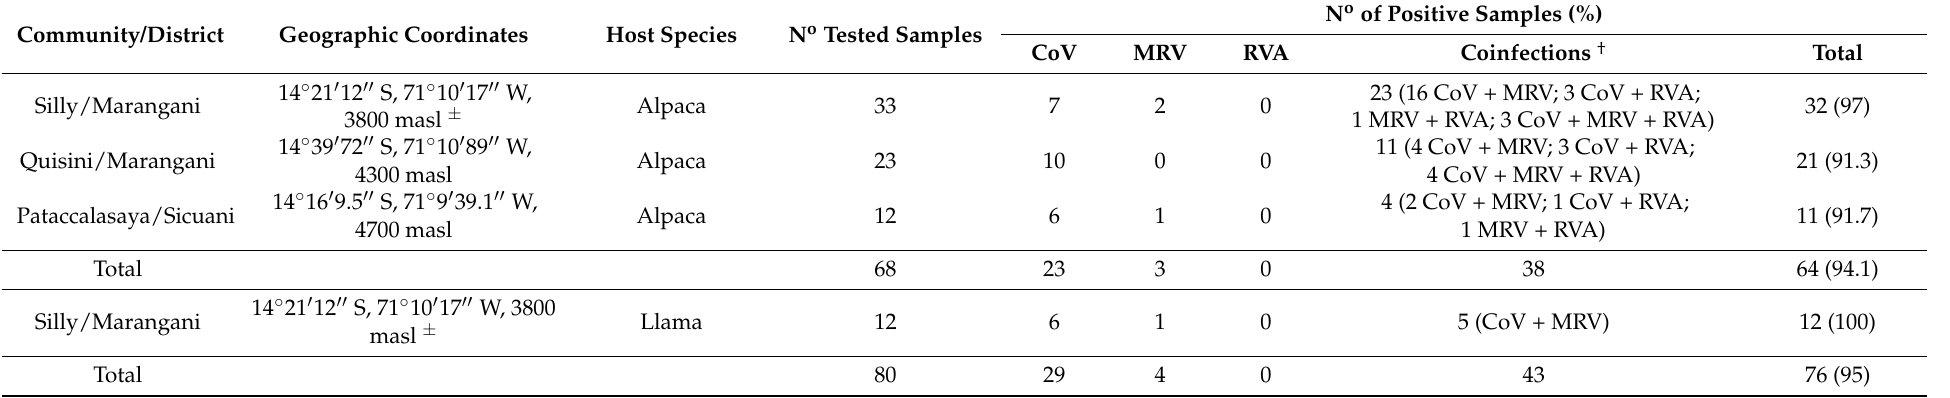
Table 2. Distribution of viral infections among alpacas and llamas in three rural communities of the province of Canchis, Peru. N o of Positive Samples (%) Community/District Geographic Coordinates Host Species N o Tested Samples MRV RVA Coinfections †